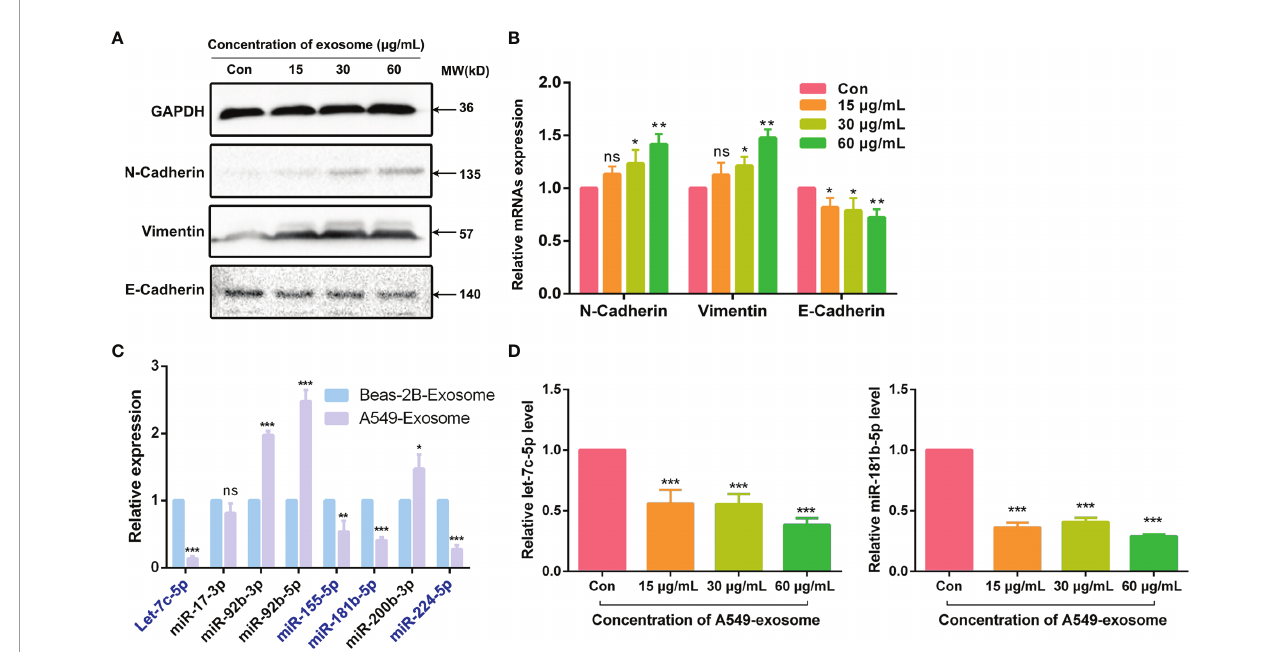
FIGURE 3 | A549-cell-derived exosomes promoted EMT in BEAS-2B cells. (A) EMT markers of BEAS-2B cells were detected by Western blot after co-cultured with A549-cell-derived exosomes. (B) Relevant mRNAs expression of EMT-speci fi c markers of BEAS-2B cells after co-cultured with A549-cell-derived exosomes were measured by RT-qPCR. (C) The expression of let-7c-5p, miR-17-3p, miR-92b-3p, miR-92b-5p, miR-155-5p, miR-181b-5p, miR-200b-3p, and miR-224-5p in exosomes secreted by A549 cells and BEAS-2B cells were compared by RT-qPCR assay. (D) The expression levels of let-7c-5p and miR-181b-5p in BEAS-2B cells treated with A549-cell-derived exosomes for 48 h by RT-qPCR. ns represents no signi fi cance; signi fi cant difference between treatment and control groups is indicated at * p < 0.05, ** p <0.01, *** p <0.001, and n ≥